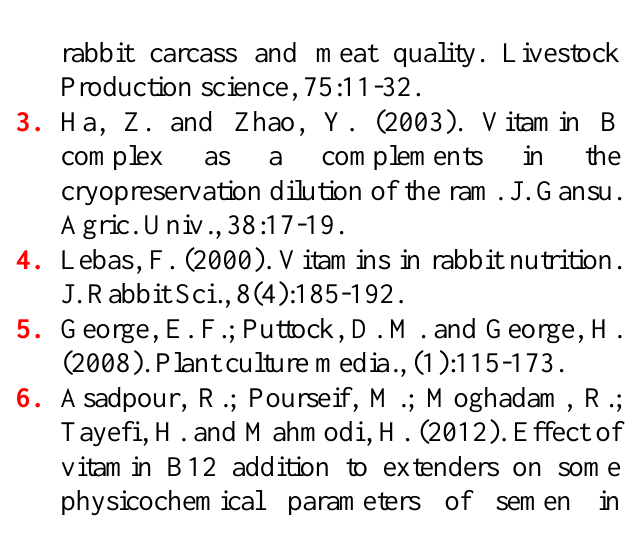
Different small letters in one column showed significant difference at the level of (P < 0.05).